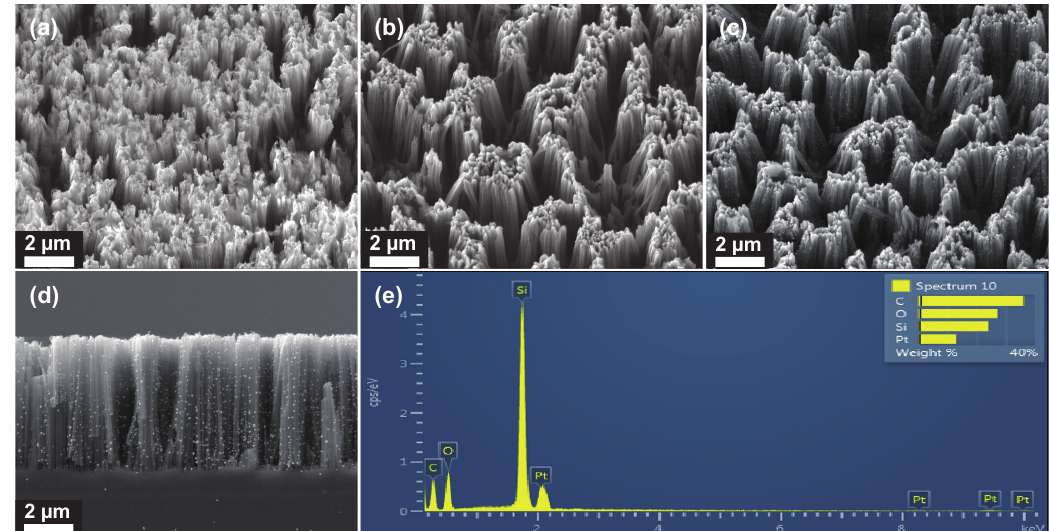
Figure 1. Scanning electron microscope images of ( a ) tilted silicon nanowire (SiNW); ( b ) tilted SiNW/C; ( c ) tilted and ( d ) cross-sectional SiNW/C@Pt; and ( e ) elemental analysis of SiNW/C@Pt.